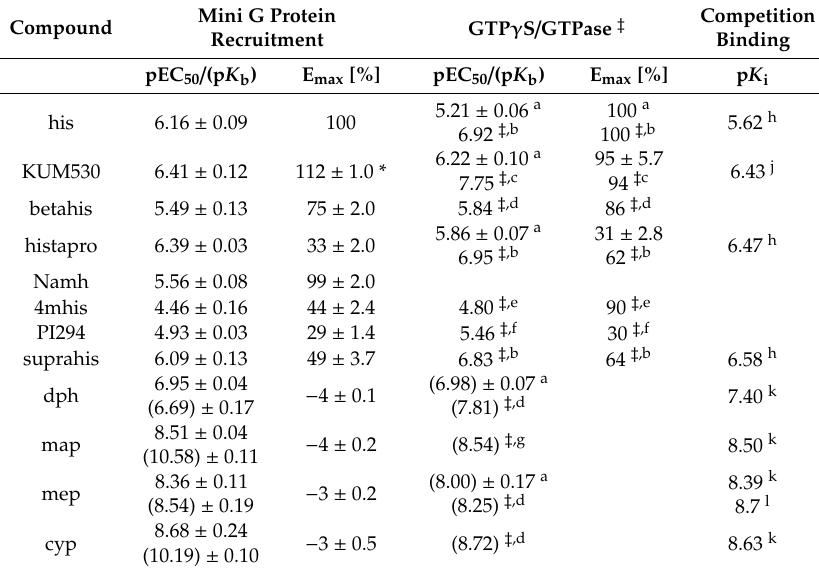
Table 1. Potencies (pEC 50 / p K b ) and e ffi cacies (E max ) of ligands at the H 1 R explored in the mini-G protein recruitment assay. Data represent means ± SEM of at least three independent experiments ( n ≥ 3), each performed in triplicate. Statistical di ff erences (*) of E max > 100% was tested using a one-sample t-test ( n = 5; α = 0.05). Functional data obtained from [S]GTP γ S and steady-state GTPase assays and ligand binding a ffi nities (p K i ) determined in radioligand competition binding assays are included for comparison.